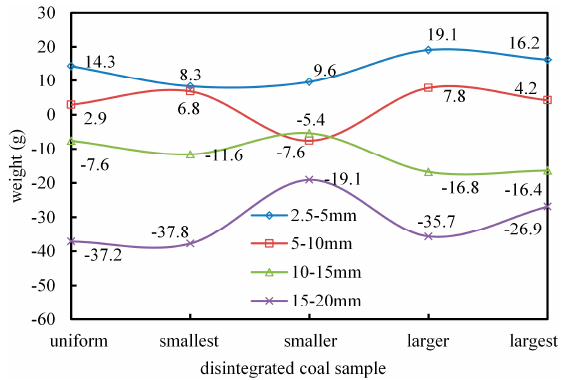
Figure 12. Weight change curves after carrying out the tests (+ means increased, − means loss).